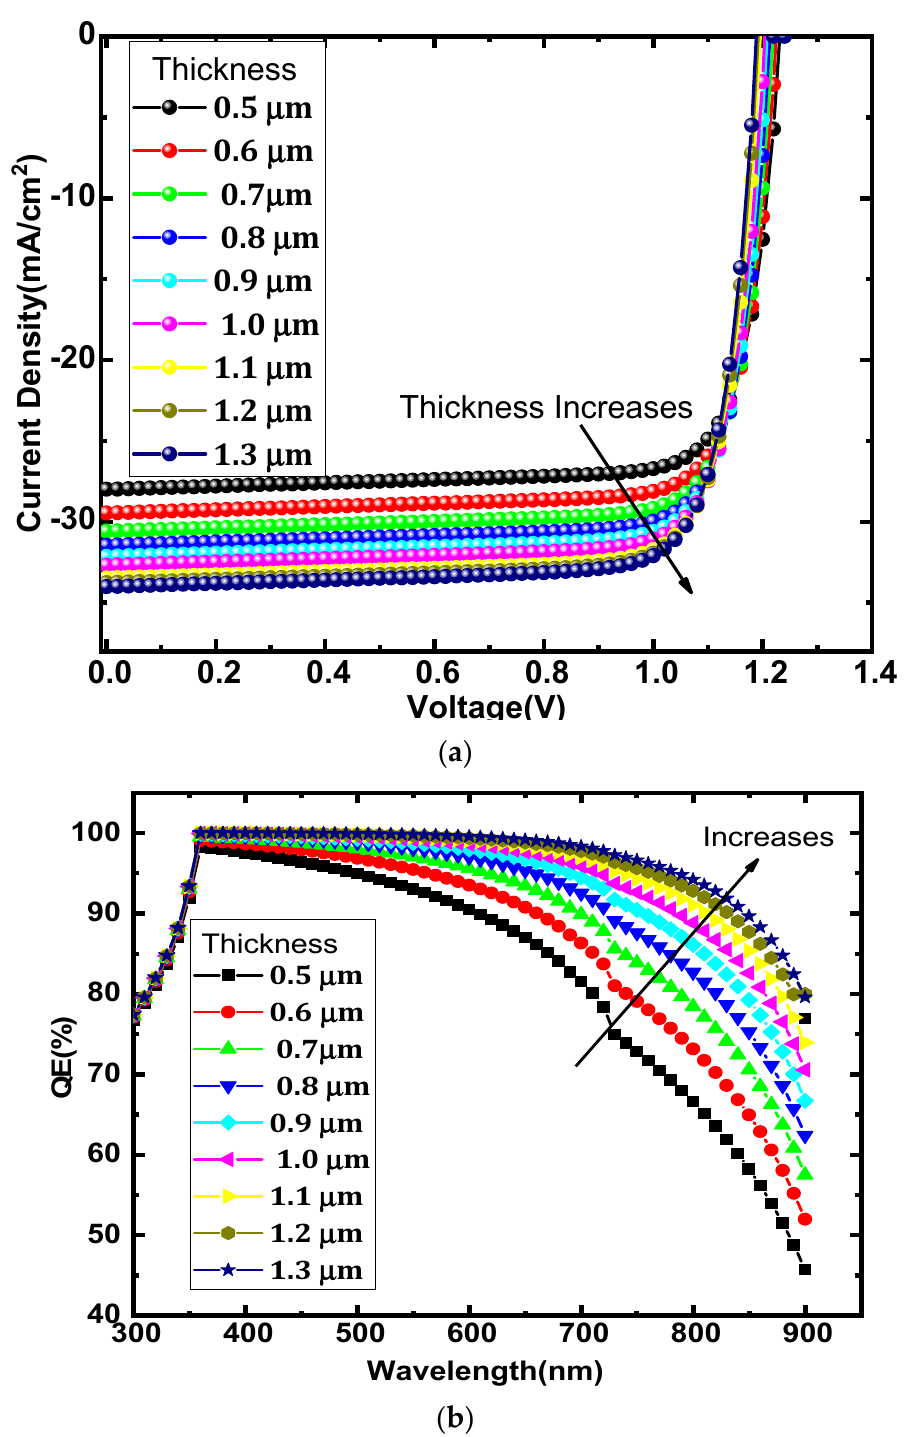
Figure 3. ( a ) Current density vs. voltage characteristics and ( b ) quantum efficiency vs. wavelength curve with varied thickness of the absorber layer.